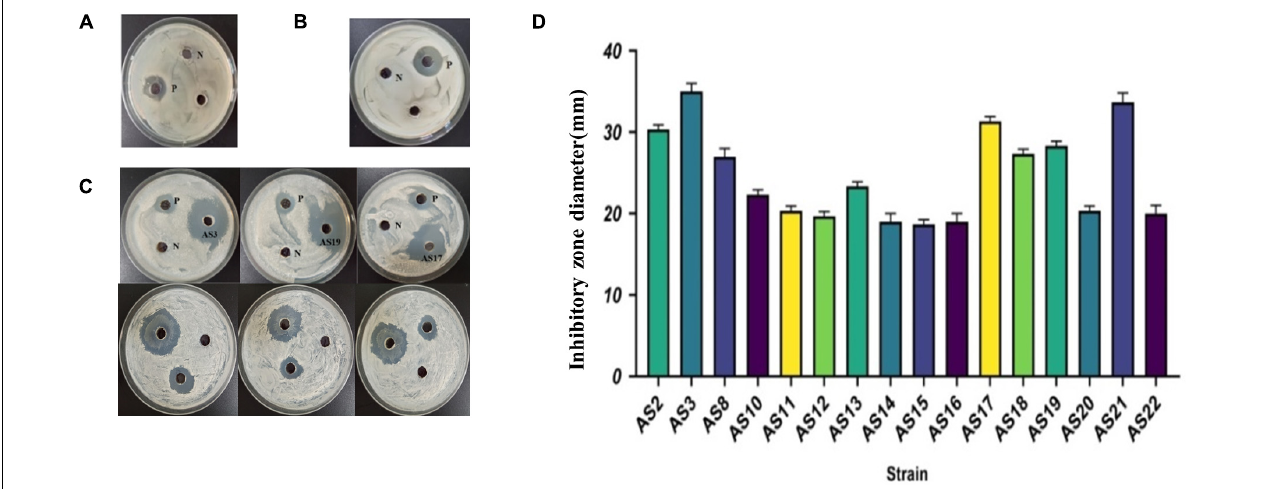
FIGURE 3 | The antimicrobial activity of CFSs of 22 isolates grown on SA. (A) Antimicrobial experiment with SA CFS against Escherichia coli N: SA medium negative control, P: Cephalosporin positive control. (B) Antimicrobial experiment with SA CFS against Staphylococcus aureus. N: SA medium negative control, P: cephalosporin positive control. (C) Antimicrobial experiment with SA CFS against C. albicans. N: SA medium negative control, P: Amphotericin positive control. (D) The inhibitory zone of 16 strains against C. albicans . Represented by individual plate experiments, the data statistics are shown in Table 1